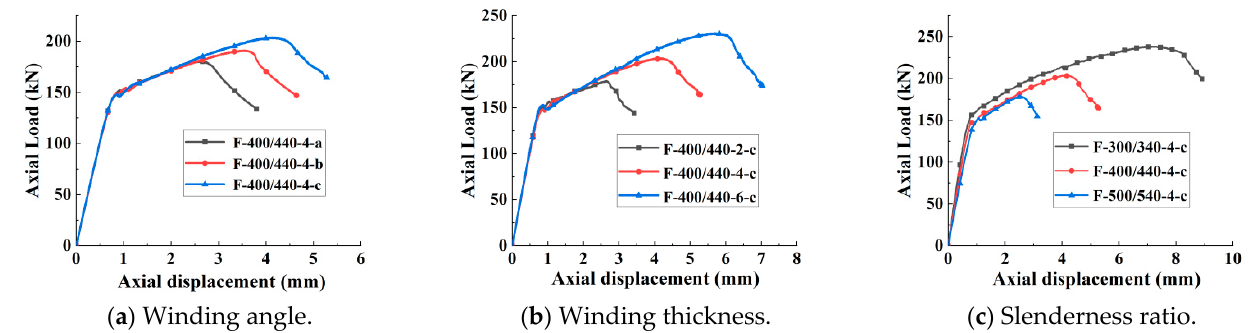
Figure 6. Comparison of load–displacement relationships between different groups.